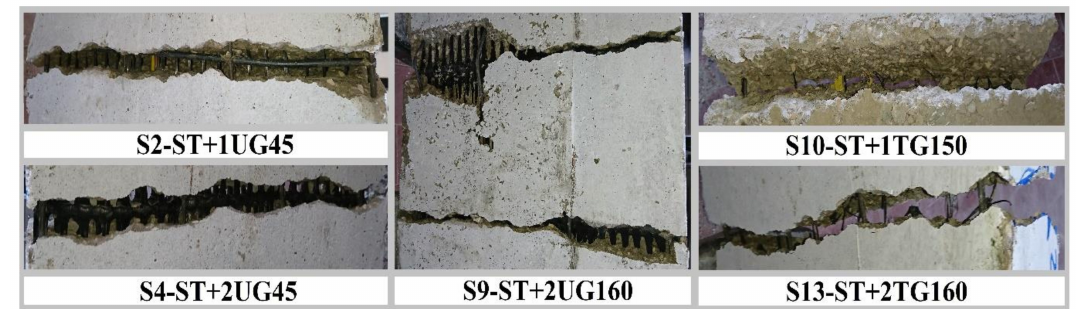
Figure 6. Some examples of geogrids’ ribs status after the failure of the concrete